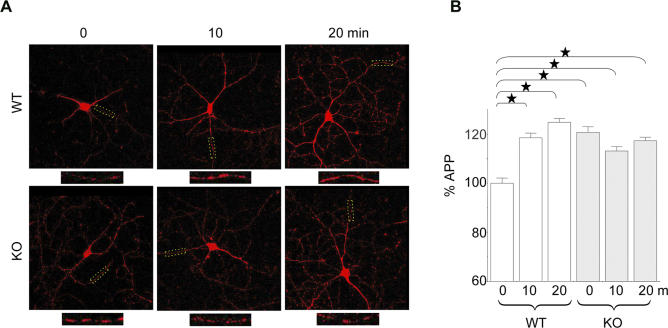
DHPG Enhances APP Translation in WT but Not fmr-1 KO Neurons(A) Immunofluorescent confocal images of WT (top) and KO (bottom) neuronal cells treated with or without DHPG (0, 10, and 20 min) and hybridized with anti-22C11 APP primary and anti-mouse rhodamine-conjugated secondary antibodies. The dashed yellow rectangles encompass segments of dendrites, which are enlarged and displayed below the photos.(B) Dendritic APP levels were quantitated with ImageJ software and plotted as a percentage of untreated WT samples. Asterisks indicate significant differences, with p < 0.001 between the pairs.